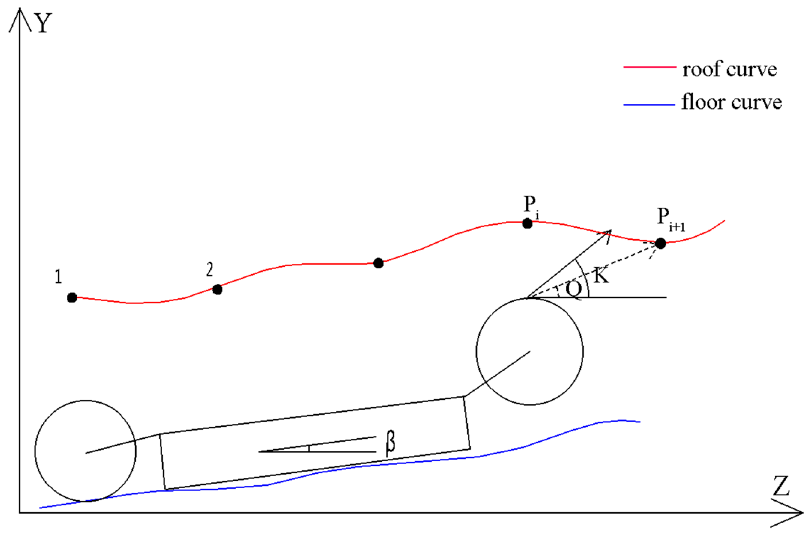
Figure 4. Automatic height-adjusting diagram.